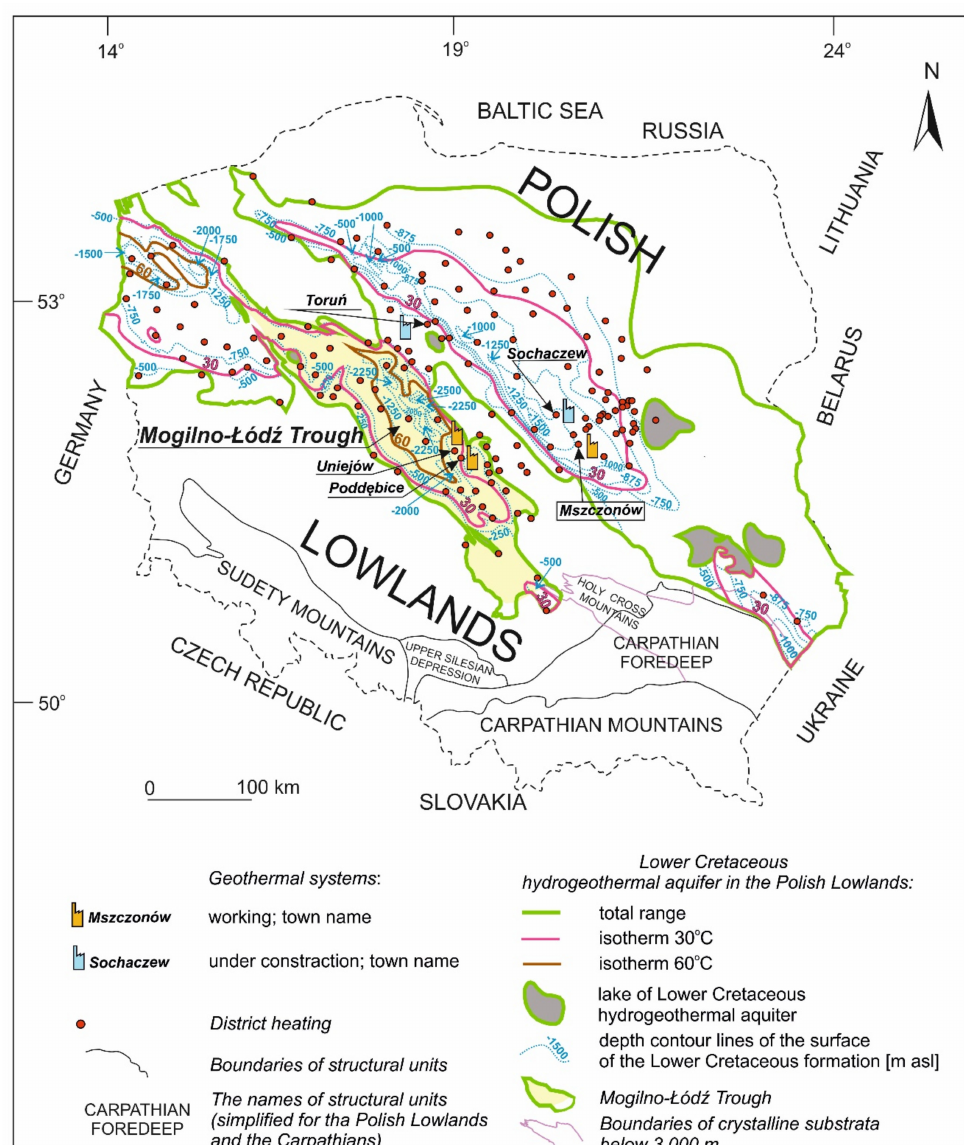
Figure 1. Locations with district heating systems being operated against the background of the boundaries of the Lower Cretaceous hydrogeothermal aquifer in the Polish Lowlands (based on